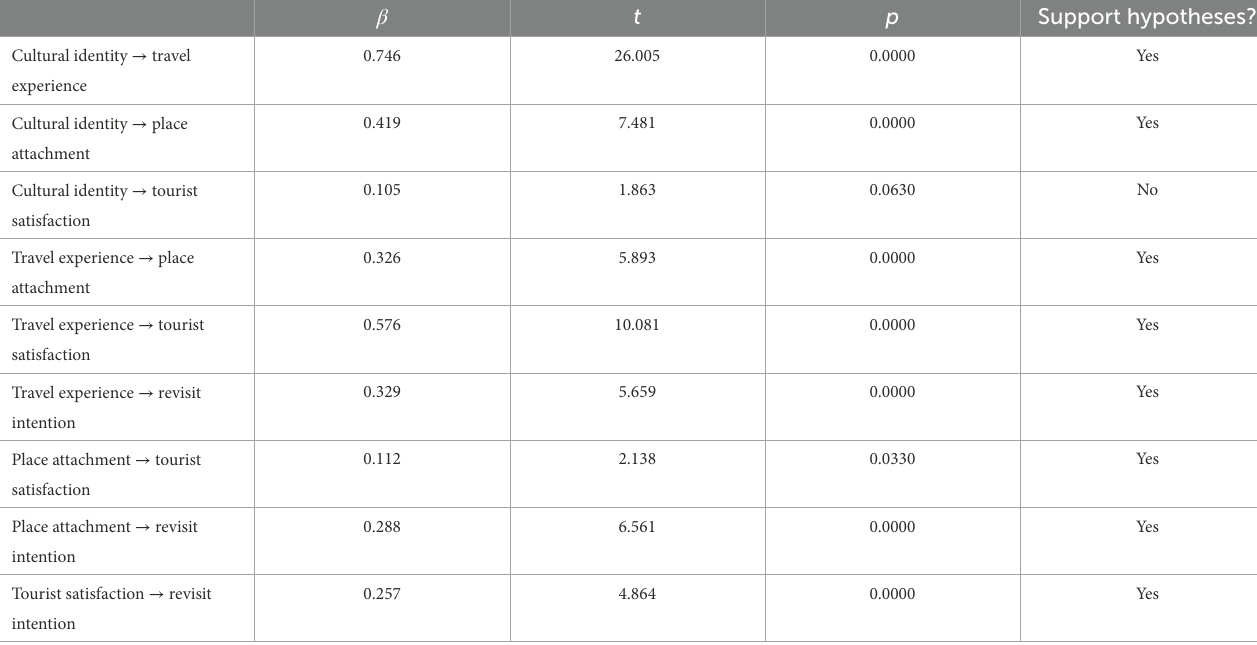
TABLE 4 The path analysis and hypothesis evaluation